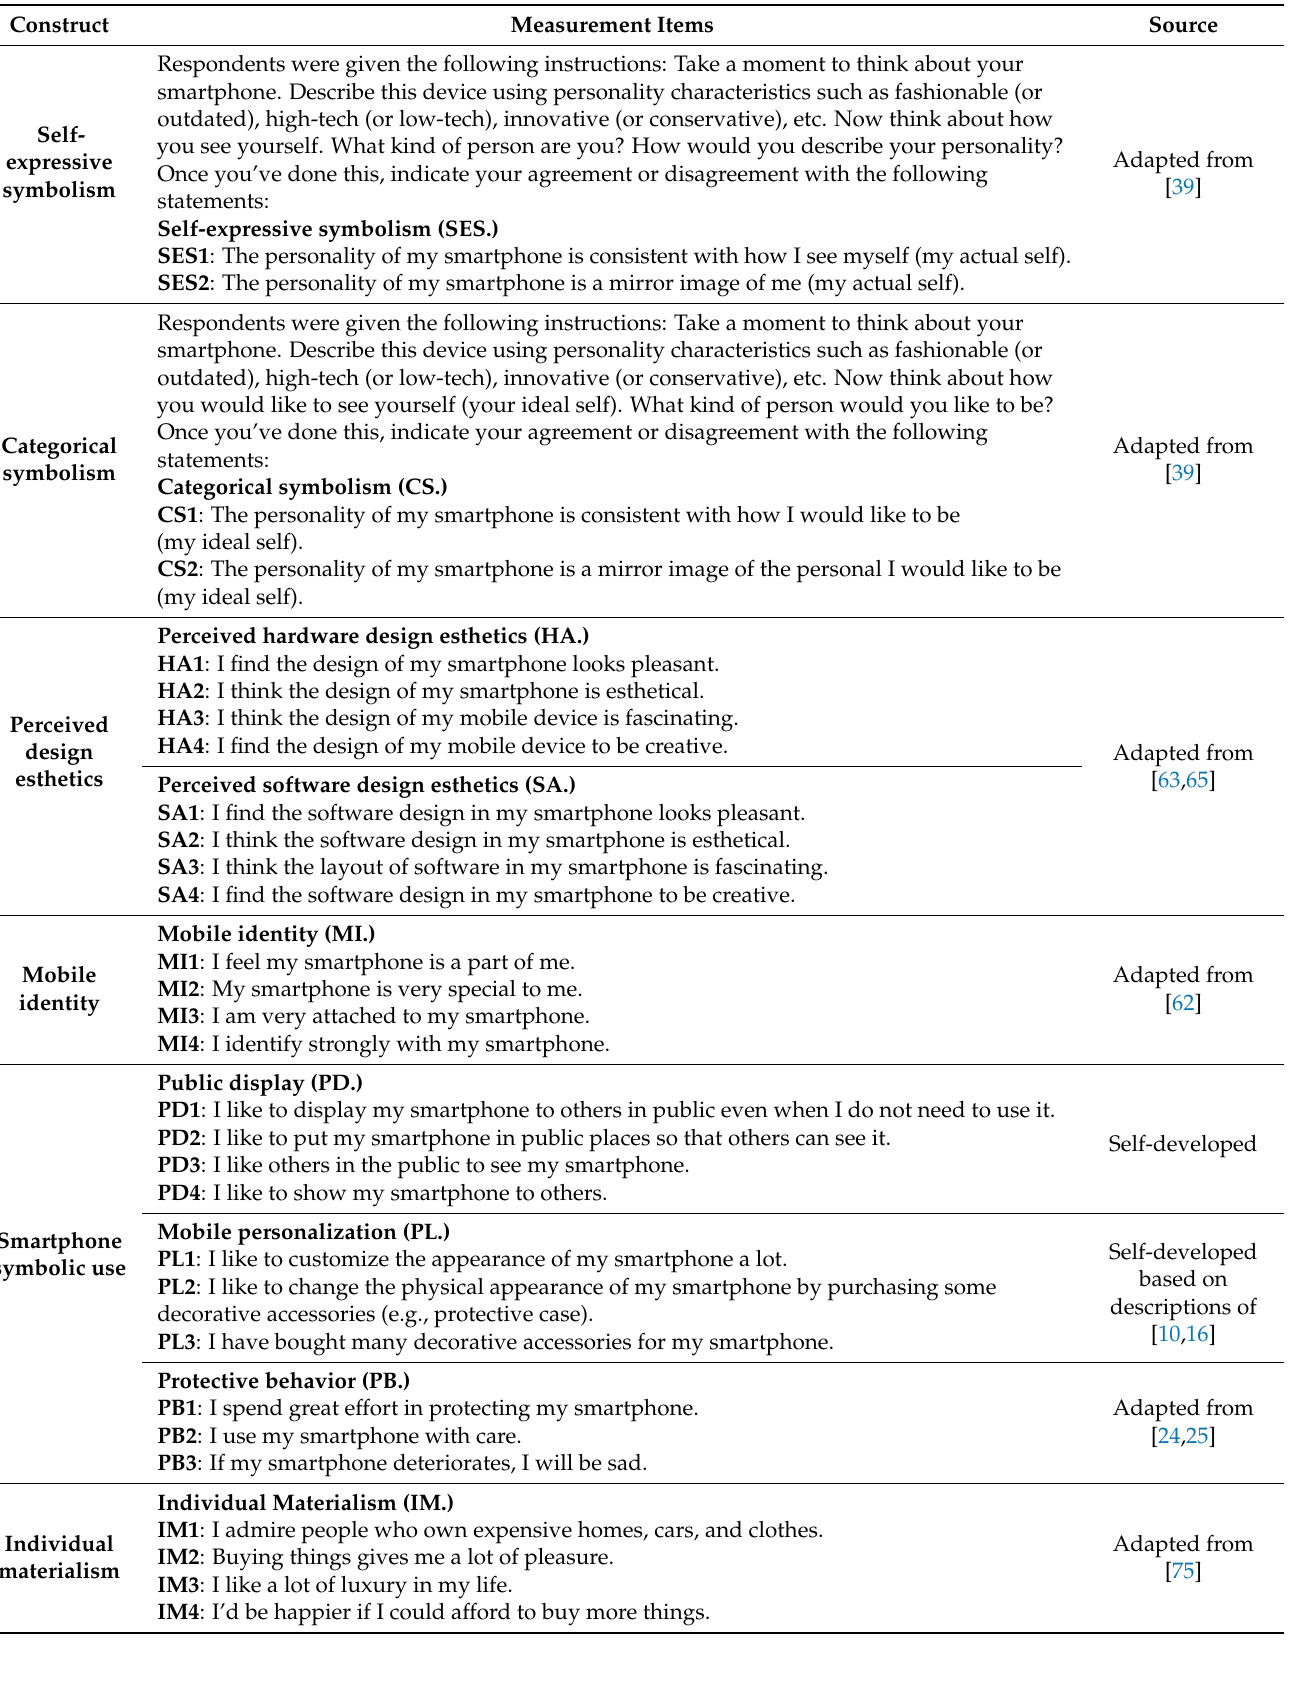
Table 3. Measurement